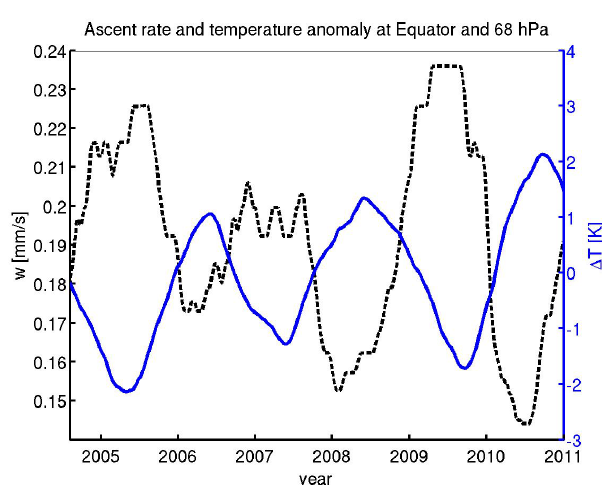
Fig. 8. The vertical ascent rate at the Equator between 68hPa and 56hPa (dashed black, left y-axis) is compared to the MLS temperature anomaly (solid blue, right y-axis) at the same latitude and pressure. The temperature time series has been smoothed by a one year forward moving average to match the method which is used to determine the ascent rate. Each value represents the average over the next year. Temperature is anticorrelated with the vertical ascent as expected.